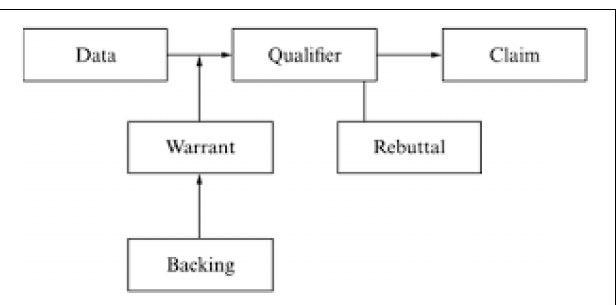
FIGURE 1 | Toulmin’s argument